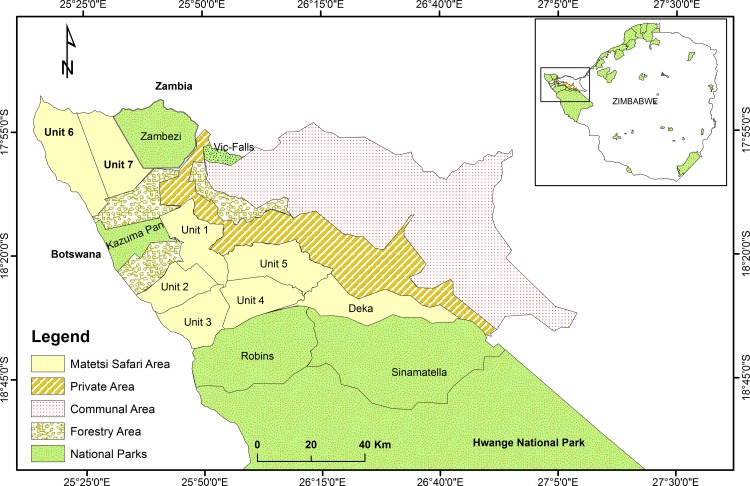
Map showing location of study area, Matetsi Safari Area and the surrounding areas (National Parks, Forestry Areas, Private Areas and Communal Areas in northwest Zimbabwe).Insert: Location of study area (solid rectangle) in Zimbabwe in relation to other protected areas Source: Muposhi, Gandiwa [70].